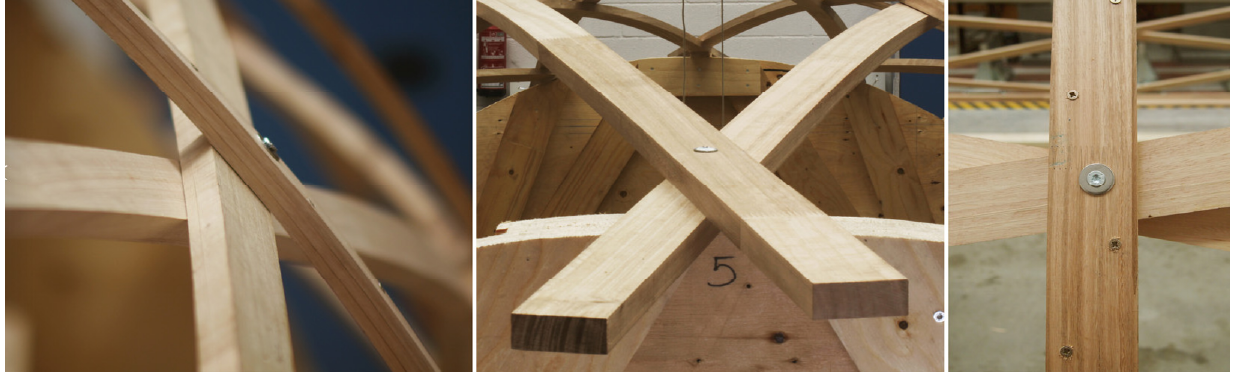
Figure 4. Joints of the TEL-gridshell lab prototype.